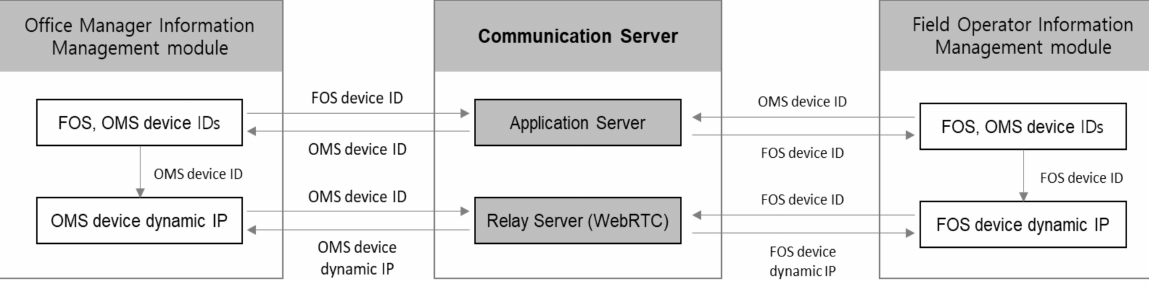
Figure 4. Devices’ IDs and IP addresses management.